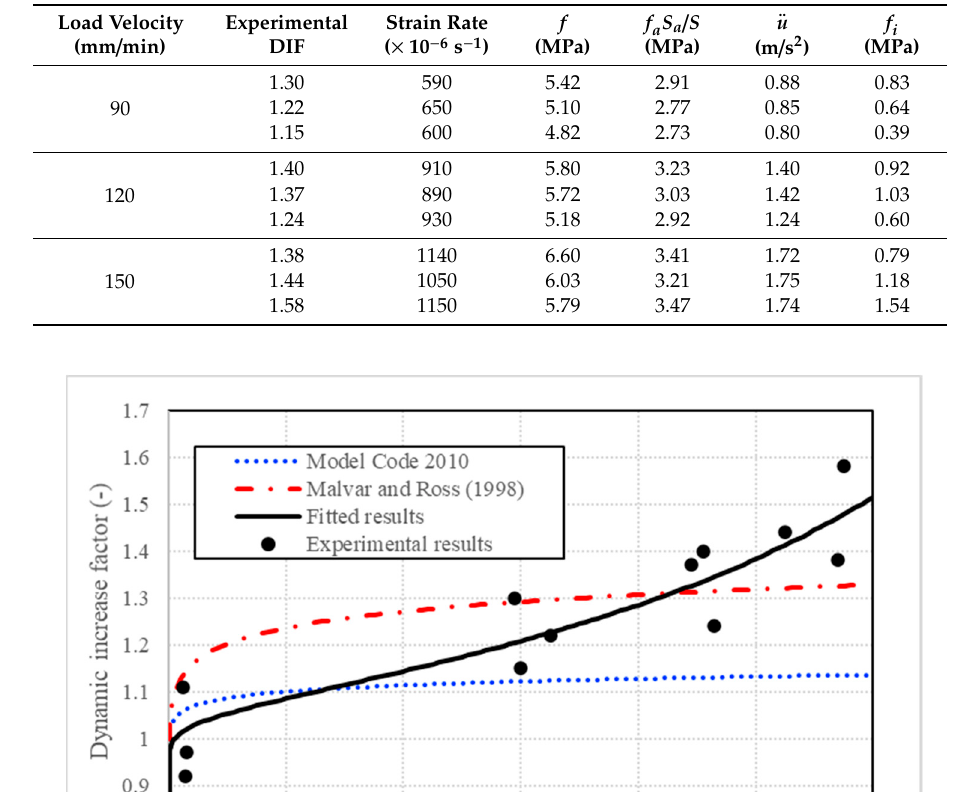
.. u is the acceleration and f i is the